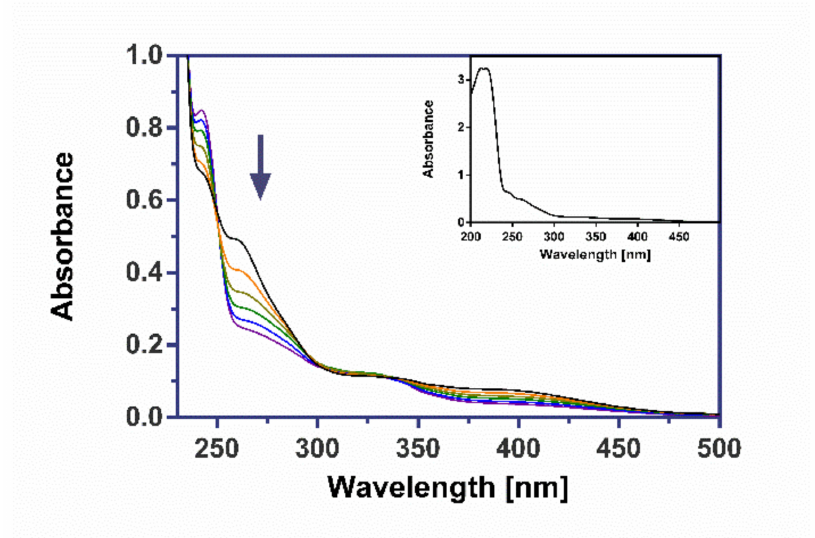
Figure 11. UV-vis spectrum of complex 3 (6.14 × 10 − 6 M) with ctDNA. The arrow indicates changes in absorbance upon increasing DNA concentration. Inset: UV-vis absorption spectrum of 3